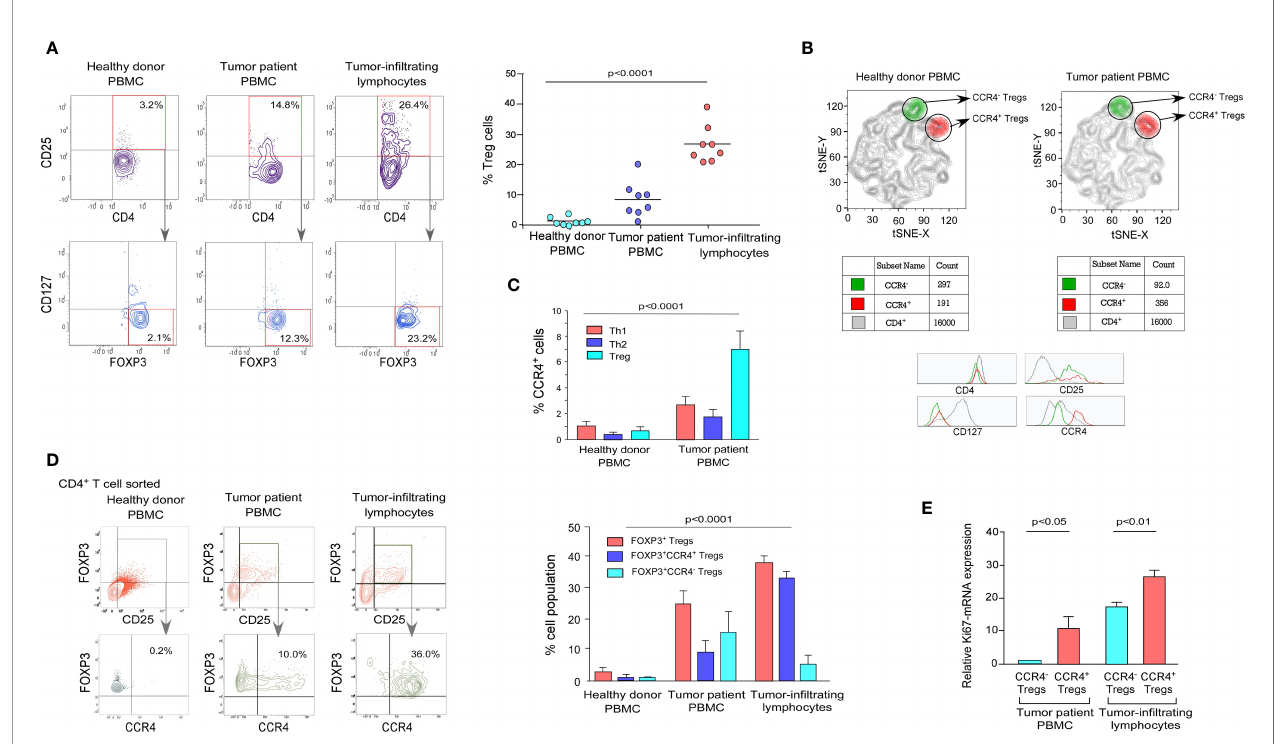
FIGURE 1 | Tumor-in fi ltrating Treg cells showed higher expression of CCR4 than the peripheral circulation in breast cancer patients. (A) Representative fl ow cytometry data of CD4 + CD25 + CD127 - FOXP3 + Tregs from the peripheral circulation of an age-/sex-matched healthy individual, breast cancer patient, and breast tumor tissue (left panel). In a scatter plot ( n = 8; right panel), percent Treg populations from different cohorts were represented. (B) Comparative t-SNE analysis of CCR4 + (shown in red/CD4 + CD25 + CD127 - CCR4 + ) and CCR4 - (shown in green/CD4 + CD25 + CD127 - CCR4 - ) Tregs within the proportion of CD4 + T cells in the peripheral circulation of an age-/sex-matched healthy individual and a breast cancer patient. (C) Graphical representation of percent CCR4 + cells in Th1, Th2, and Treg subpopulations in the peripheral circulation of age-/sex-matched healthy donors and breast cancer patients. (D) Flow cytometric representation of CD4 + CD25 + FOXP3 + CCR4 + Tregs in the peripheral circulation of a healthy donor and a breast cancer patient, as well as tumor tissue (left panel). Percentage of CD4 + CD25 + FOXP3 + , CD4 + CD25 + FOXP3 + CCR4 + , and CD4 + CD25 + FOXP3 + CCR4 - Tregs in the peripheral circulation of age-/sex-matched healthy donor and breast cancer patients, as well as tumor tissue (right panel). (E) Graphical representation of Ki67-mRNA expression in CCR4 - and CCR4 + Treg compartments separated from peripheral blood and tumor tissue. As an internal control, GAPDH was used. The values are the mean ± SD of three sets of independent